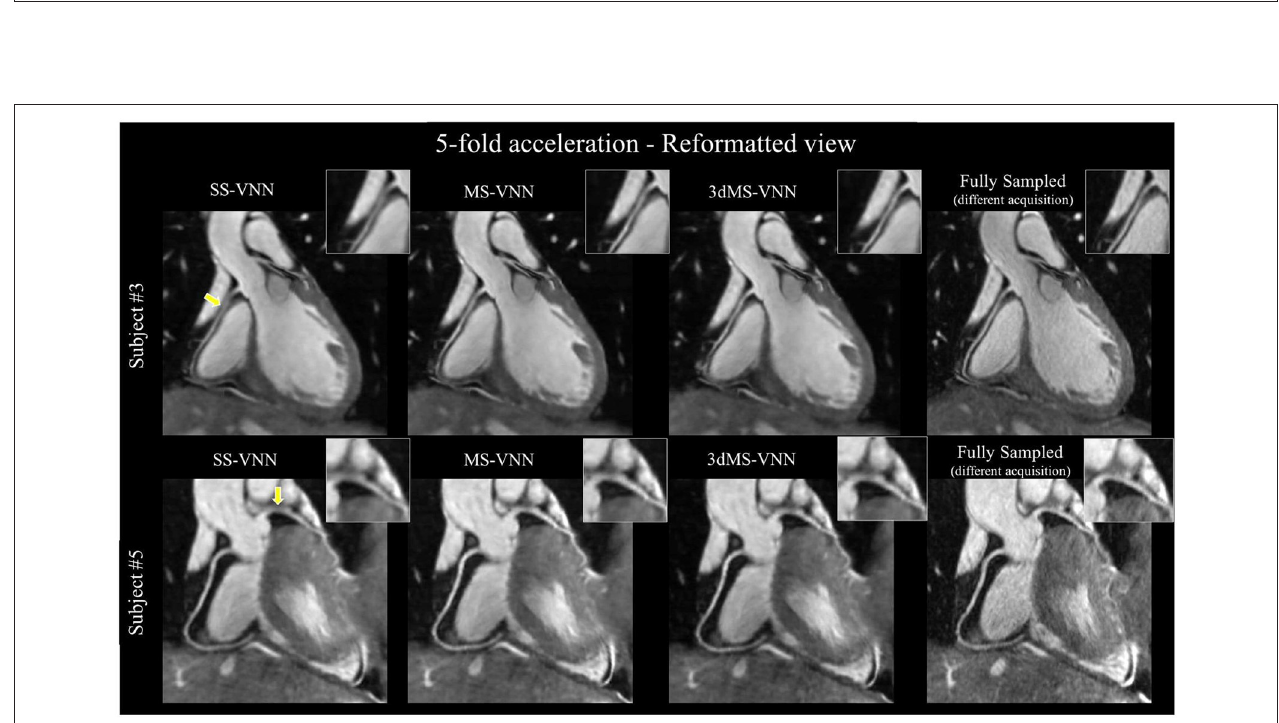
FIGURE 11 | CMRA images reconstructed with a single-scale VNN (SS-VNN), the multi-scale VNN (MS-VNN), and a pseudo 3D multi-scale VNN (3dMS-VNN). CMRA images were reformatted along the left (LAD) and right (RCA) coronary arteries, for two representative healthy subjects. Fully sampled and undersampled acquisitions with acceleration factor of 5 × are shown. VNN, variational neural network. Adapted with permission from Fuin et al. ( 72).